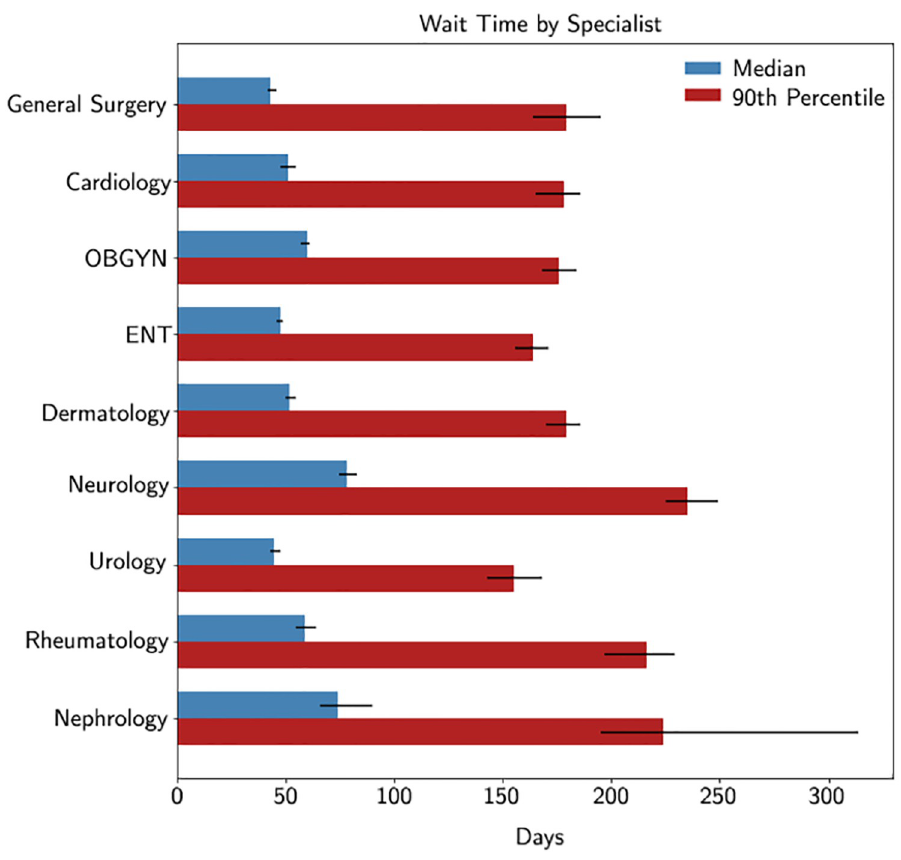
Fig 4. The estimated median and 90 th percentile wait time from family physician referral to specialist visit for nine specialties. The error bars represent the 95% confidence interval (arrived at by bootstrapping).